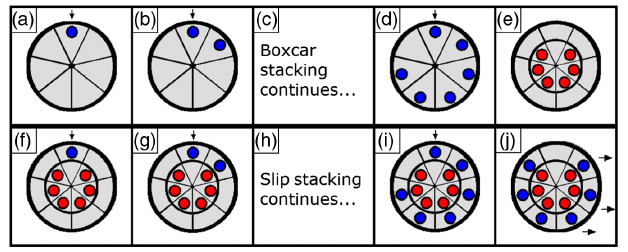
FIG. 1. The Booster batch is represented by the circles and the Recycler (or Main Injector) is represented by the seven-sector wheel. (a – d) Six Booster batches injected each Booster cycle (boxcar stacking). (e) The rf frequency is gradually lowered in between the sixth and seventh batch injection. (f – i) Subsequent batches are injected into the gap left by the first six and gradually overlap. (j) When the first six and last six batches are aligned, the batches are extracted to the Main Injector (if needed) and both beams are accelerated as rf cavities with a small frequency difference between them. Each beam is synchronized to one rf cavity and perturbed by the other rf cavity.